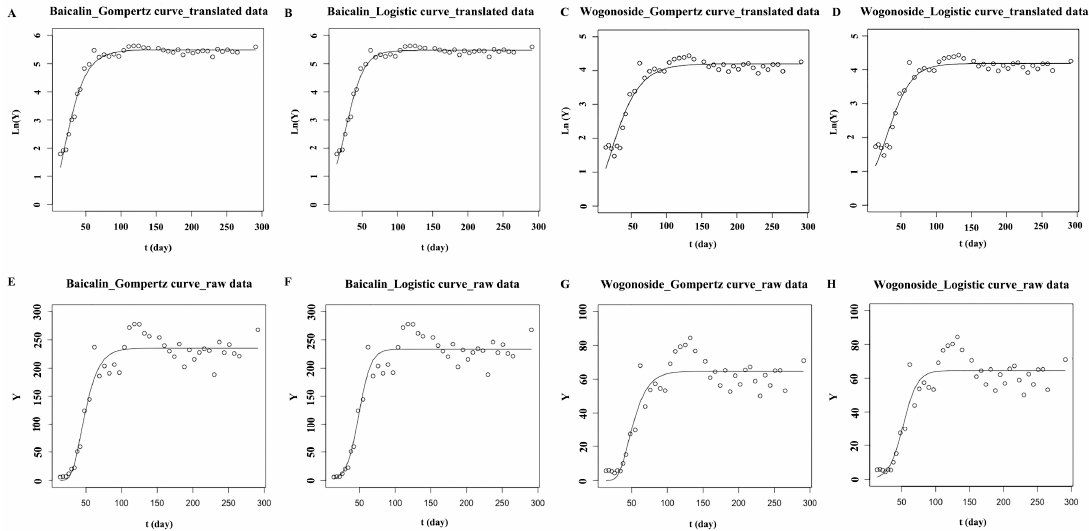
Figure 6. The growth curves fitting for baicalin and wogonoside in root of S. baicalensis . ( A , C ): the Gompertz growth curves fitted by the translated data of the content of baicalin and wogonoside; ( B , D ): the Logistic growth curves fitted by the translated data of the content of baicalin and wogonoside; ( E , G ): the Gompertz growths curve fitted by the raw data of the content of baicalin and wogonoside; ( F , H ): the Logistic growth curves fitted by the raw data of the content of baicalin and wogonoside; Y meant the contents of the quantified compounds in freeze-dried samples; Ln(Y) meant that the raw data of contents were translated by taking logarithm.